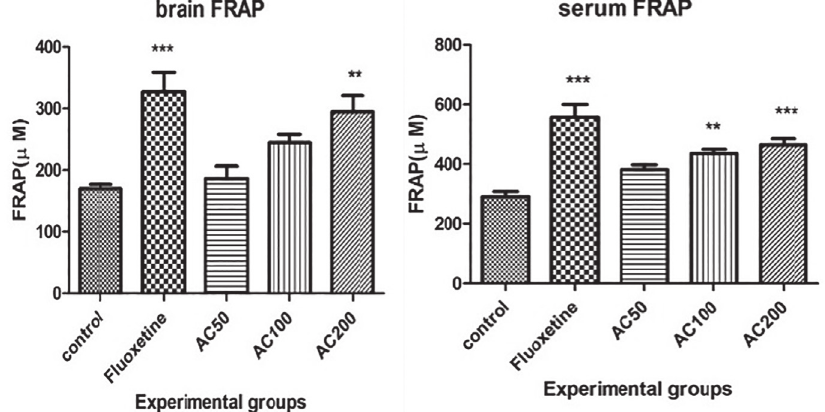
FIGURE 4 (A, B) - Effect of Adiantumcapillus-veneris extract on serum and brain antioxidant levels; *** = ( P < 0.001); ** = ( P < 0.01); AC: Adiantumcapillus-veneris.